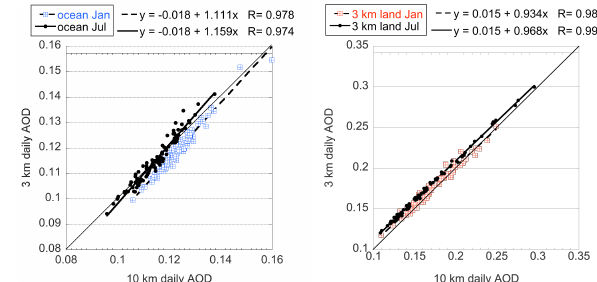
Fig. 7. Difference between 3km daily global mean aerosol opti- cal depth (AOD) at 550nm and the same at 10km for over ocean (left) and over land (right). Positive differences indicate that the 3km AOD is higher than the 10km AOD.